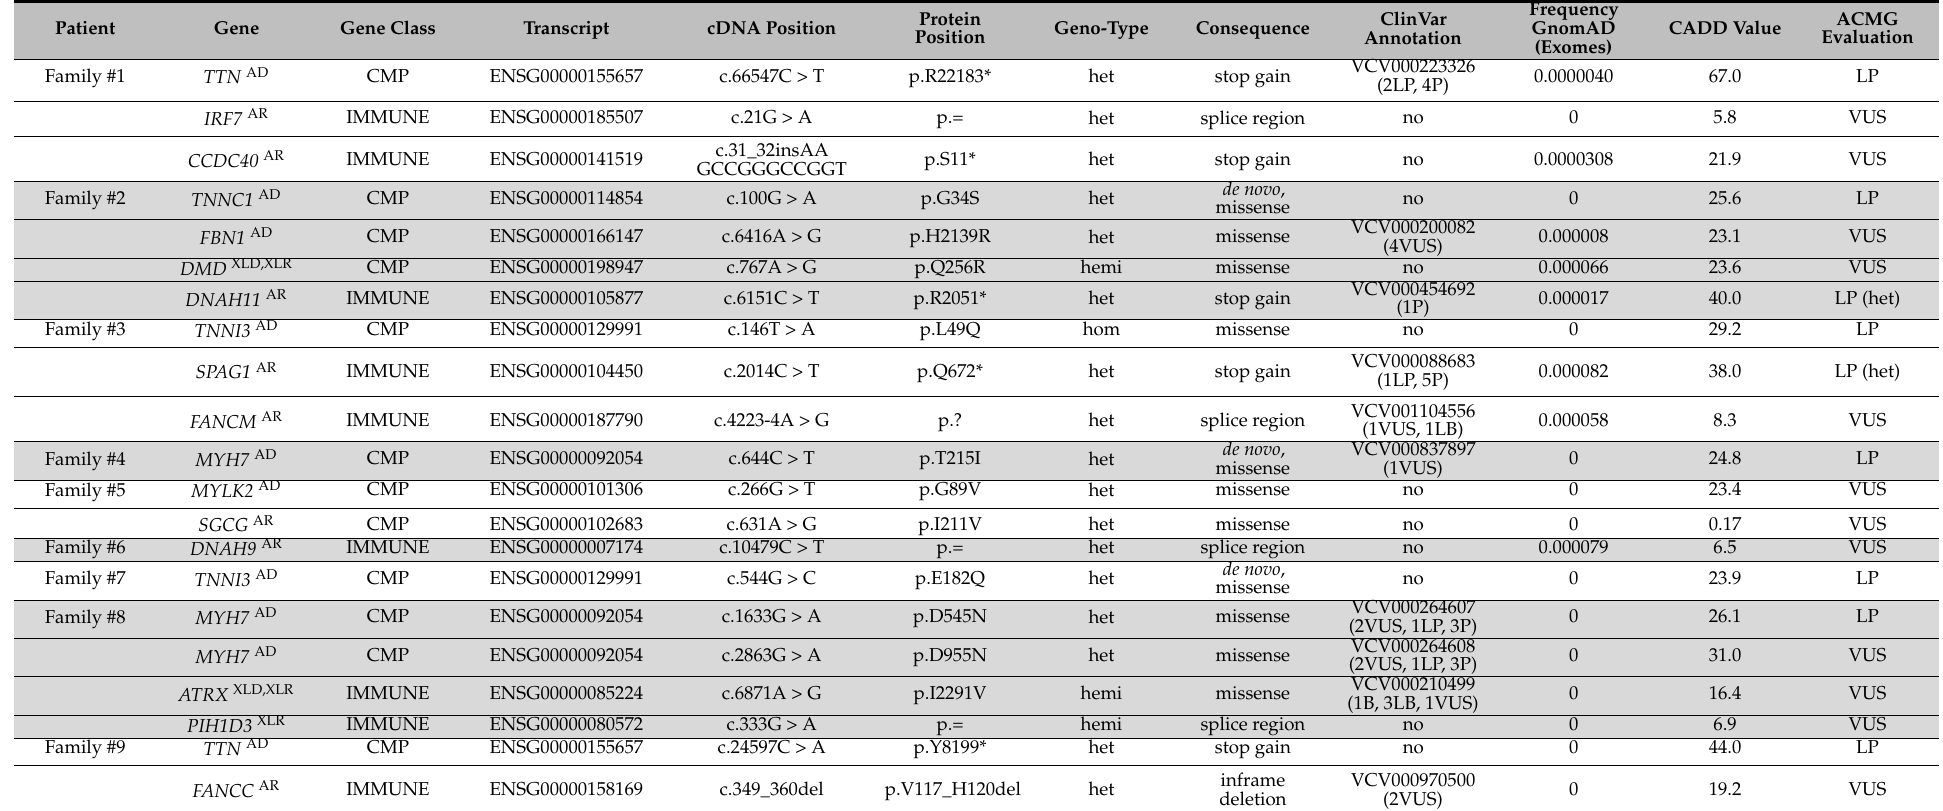
Table 2. Genetic CMP and immune disease